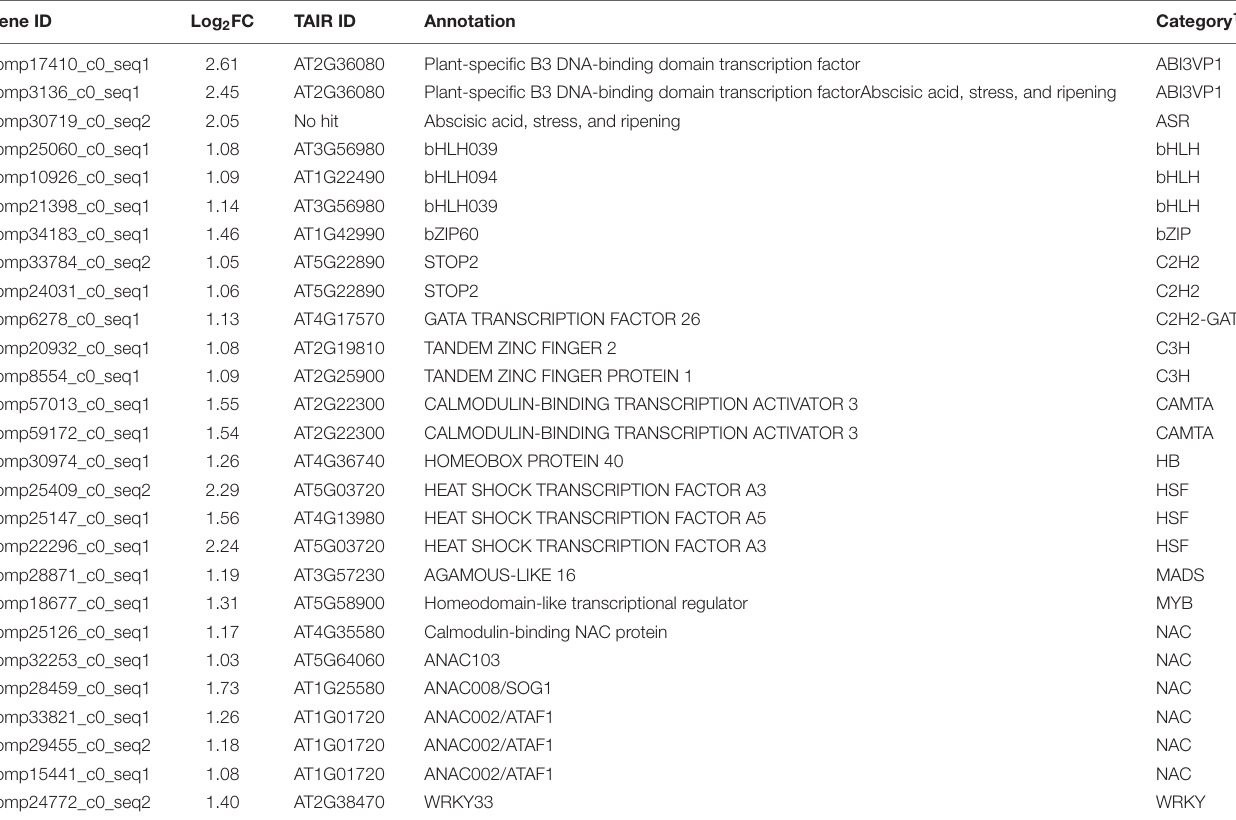
TABLE 2 | Al up-regulated genes encoding transcription